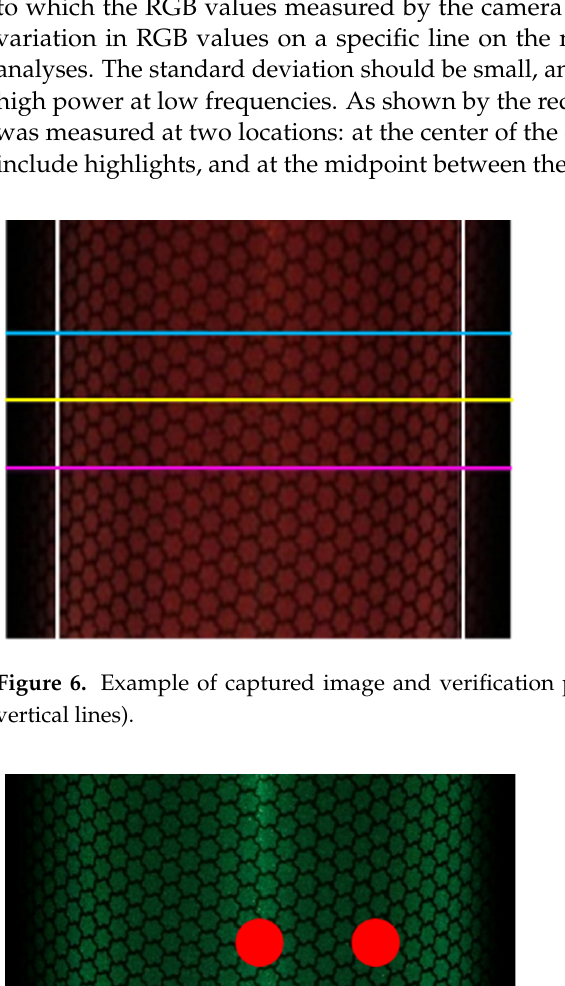
Table 3. Standard deviation of captured RGB values on the calibrated area (green projection onto encapsulated lens type).